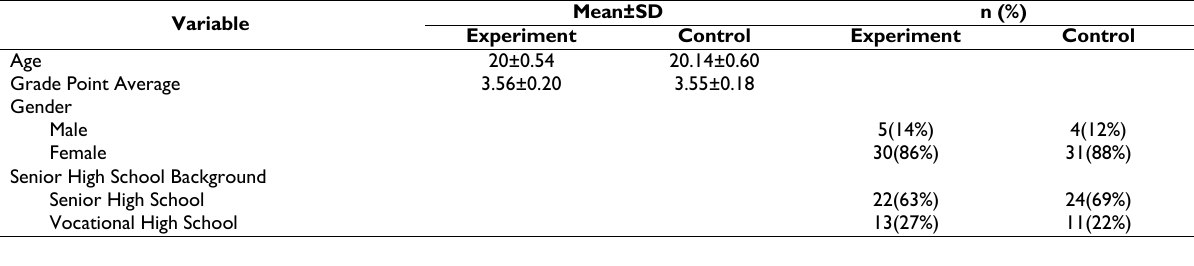
Table 2. The effects of illness script method on clinical reasoning of undergraduate nursing students (n = 70) Variable Group